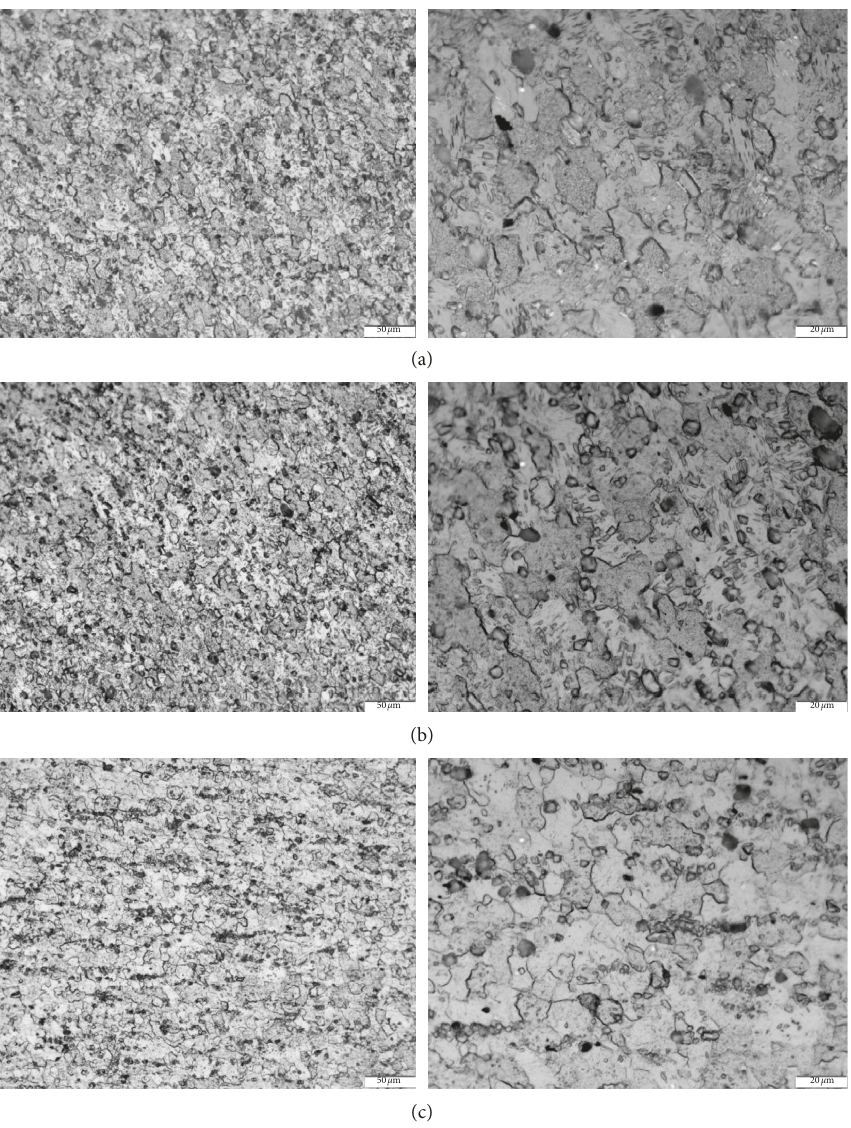
Figure 4: The microstructure of the stir zone (SZ) for friction stir welded samples at 1070rpm and three feed rates: (a) 36mm/min; (b) 70mm/min; (c) 140mm/min. Left and right columns correspond to the same location but different